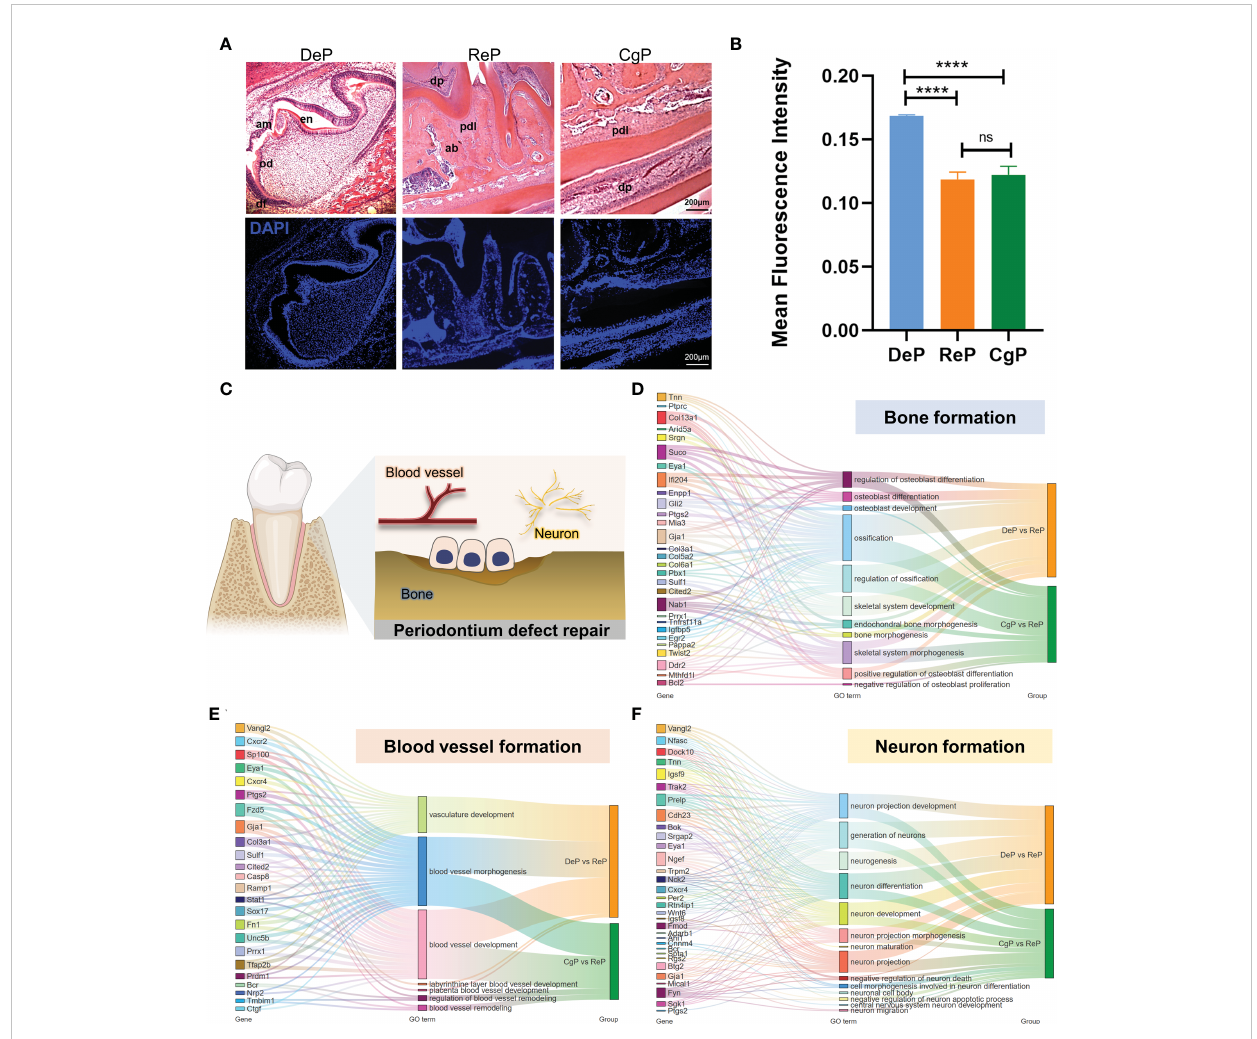
FIGURE 5 Comparison of the characteristics of tissue formation processes. (A) H&E staining and immuno fl uorescence staining of dental follicles and periodontium in mouse mandibular in sagittal sections. (B) The mean fl uorescence intensity of DAPI was used to represent the cell density in the tissue. ****p < 0.0001. (C) Diagram of the formation of several vital tissues during periodontal remodeling. (D – F) Sankey maps are used to show critical genes and pathways involved in bone, blood vessel, and neuron formation. ns, no signi fi